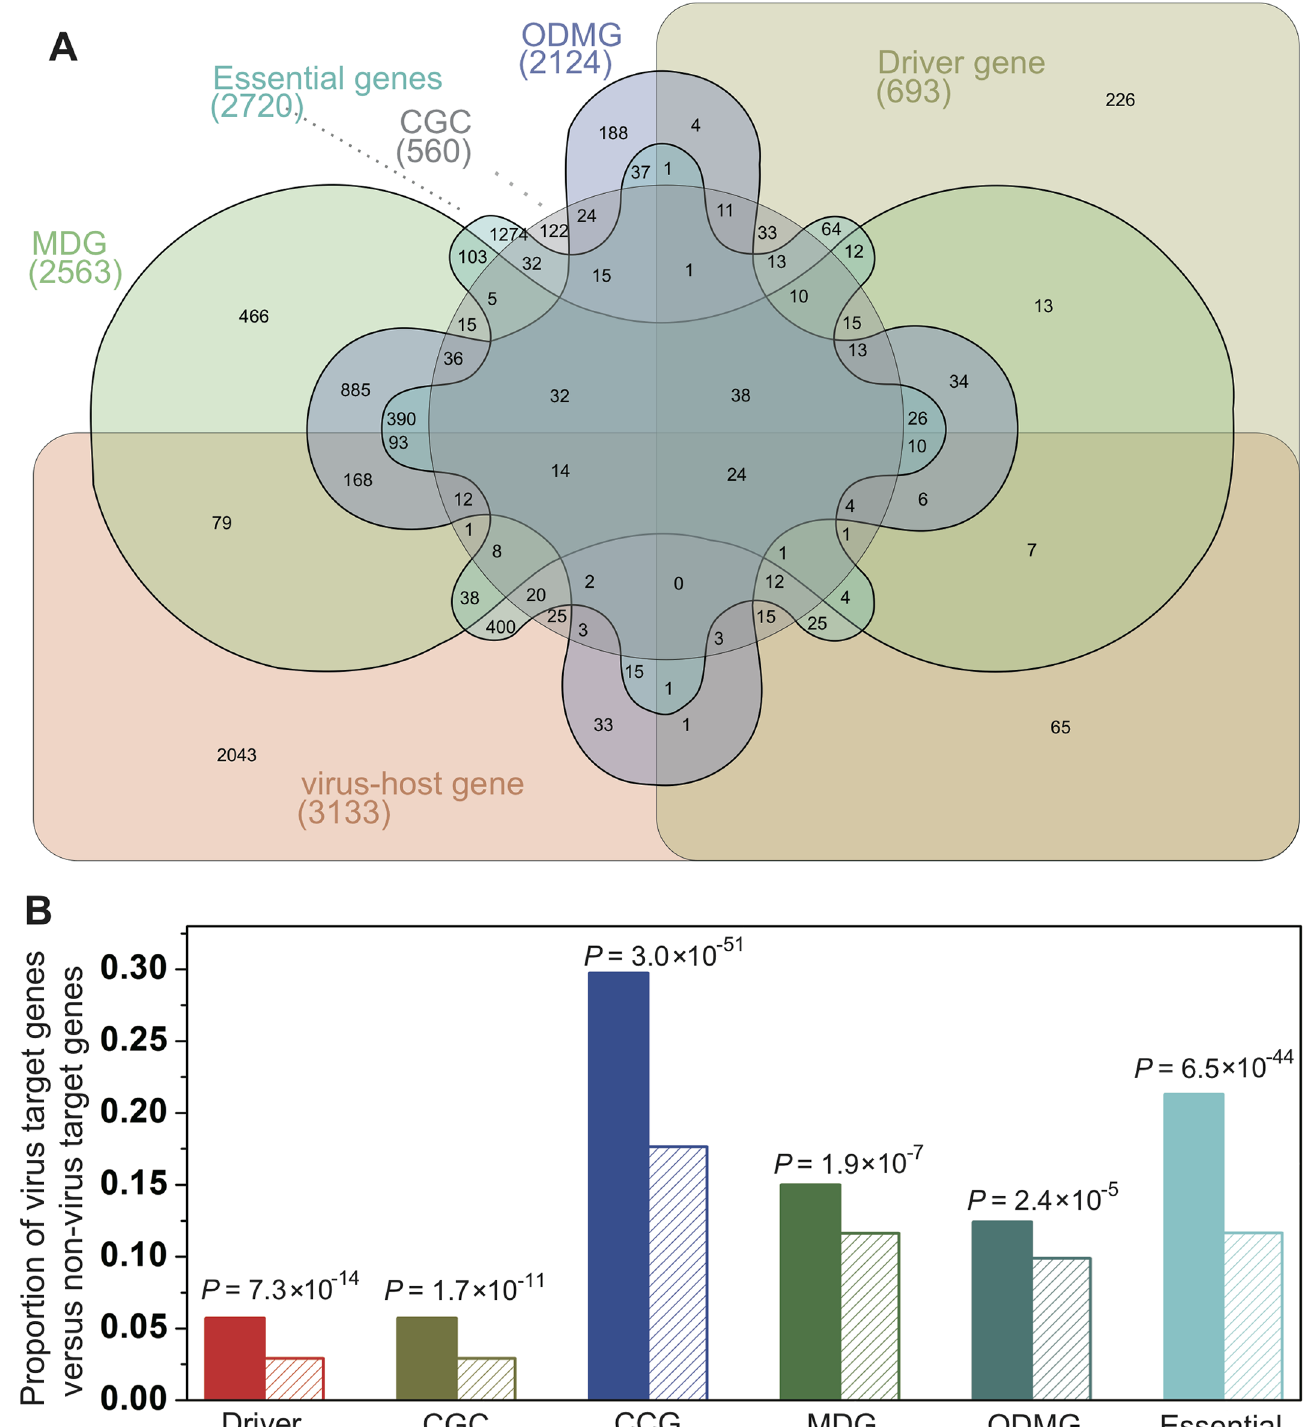
Fig 5. Disease etiology analysis of virus target genes. ( A ) Venn diagram denoting the overlap among virus-target genes (Host genes), genes whose mutations are significantly associated with cancer (Driver), genes in the Cancer Gene Census (CGC, experimentally validated cancer genes), the catalogue of cancer genes (CCG), Mendelian disease genes (MDG), orphan-disease mutated genes (ODMG), and essential genes (Essential). ( B ) Disease gene enrichment analysis of virus-target genes (solid bars) versus nonvirus-target genes (striped bars). P values are calculated using Fisher ’ s exact